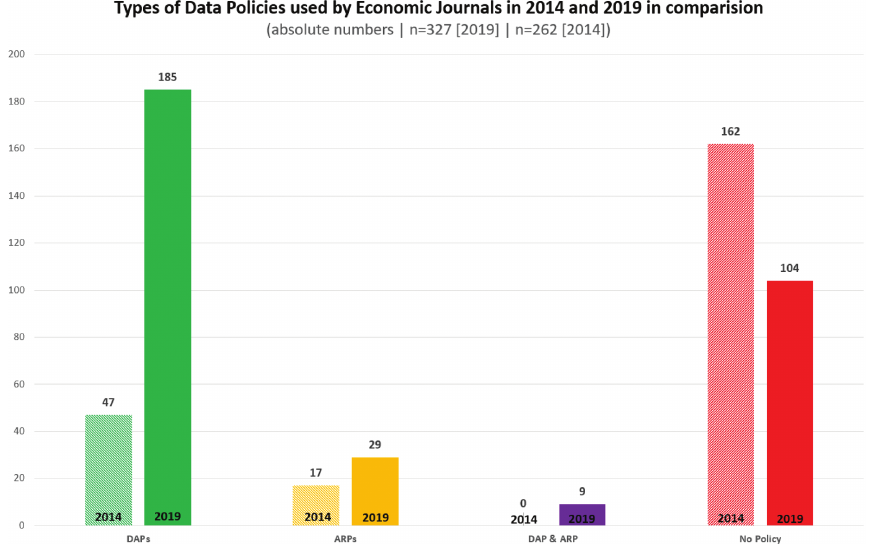
Fig. 5: Data policies of economics journals in 2014 and 2019